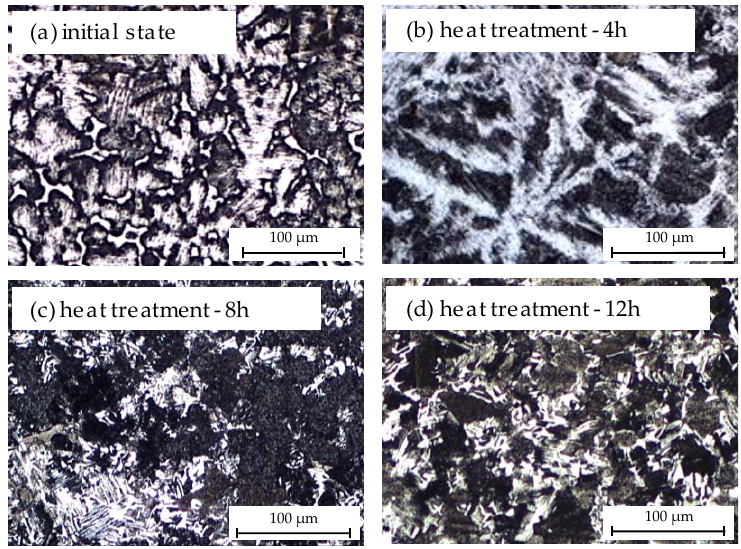
Figure 9. Cross sections of a Ti–47Al alloy in initial state ( a ) and after heat treatment of 4 h ( b ), 8 h ( c ), and 12 h ( d ).